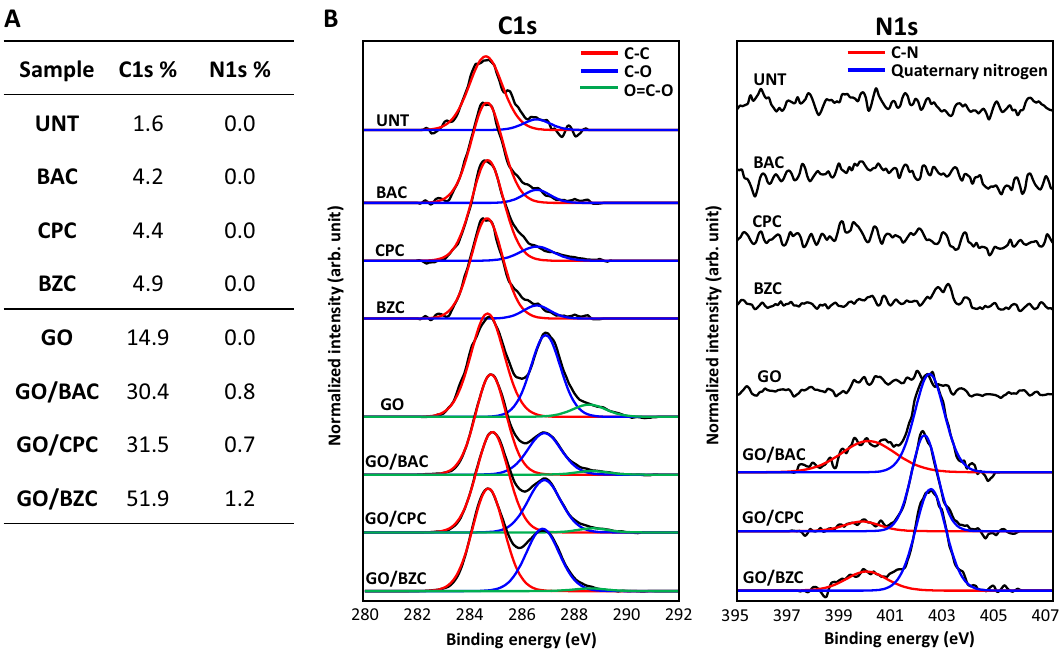
Figure 2. XPS analysis of GO/CSAA on quartz substrate. ( A ) C and N content. ( B ) XPS spectral analysis of C1s and N1s. BAC benzalkonium chloride, BZC benzethonium chloride, CPC cetylpyridinium chloride, CSAA cationic surface active agent, GO graphene oxide, XPS X-ray photoelectron spectroscopy, UNT